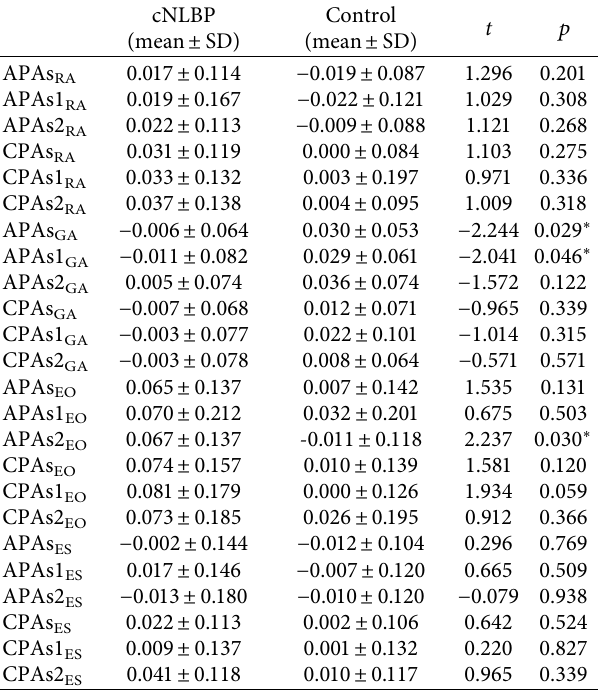
Table 4: The muscle iEMGs between the cNLBP and control groups in the external perturbation task.